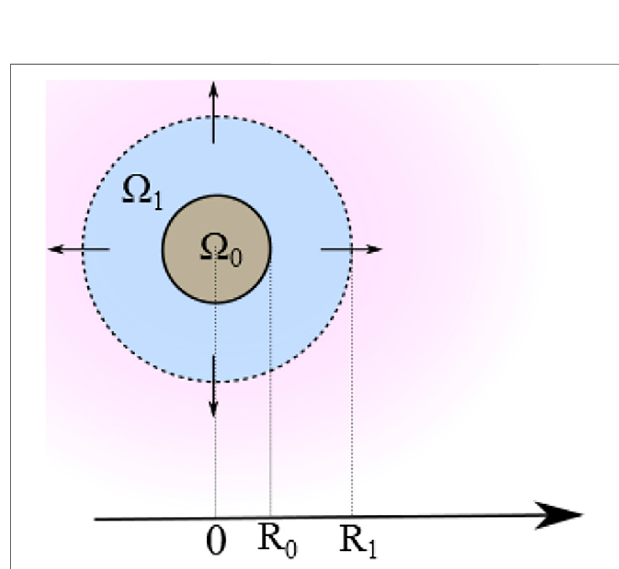
FIGURE 2 | Schematic of the 2D cross-section of a multilayer system comprising aninternal core Ω 0 and LbL-equivalent externalshell Ω 1 ( fi gure not to